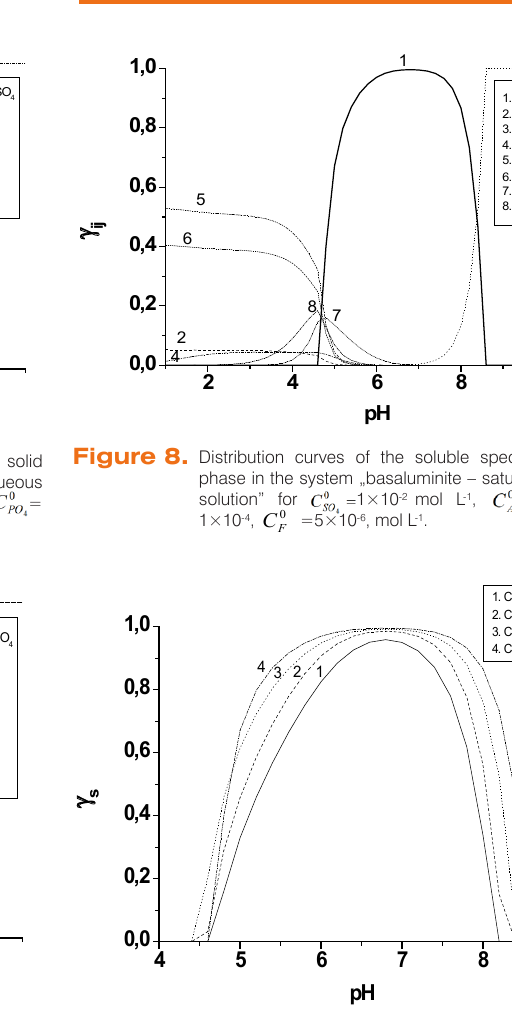
Figure 6. phase in the system „basaluminite – saturated aqueous solution” for